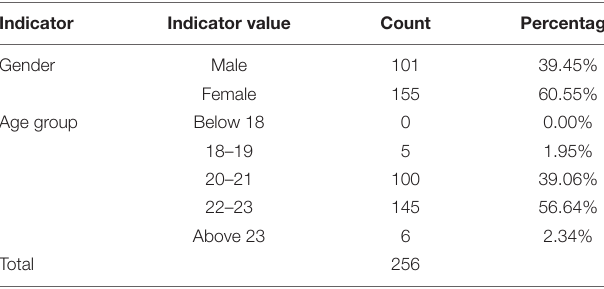
TABLE 1 | Demographic characteristics of students